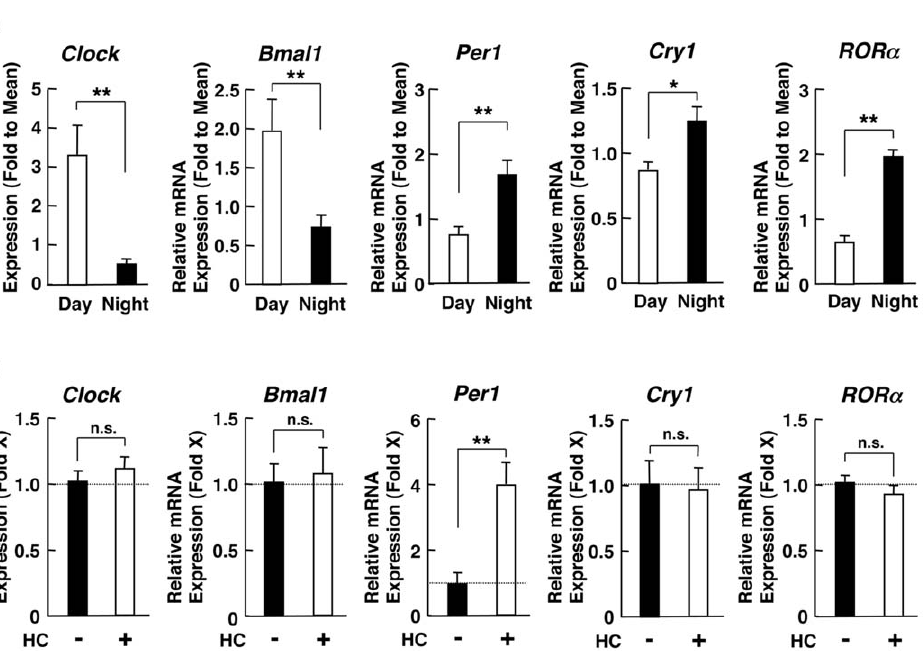
Figure 2. Daily change of CLOCK-related gene mRNA expressions in PBMCs (A) and their response to hydrocortisone in EBV- transformed peripheral lymphocytes (B). A: Morning and evening mRNA expression of CLOCK-related genes in PBMCs. Relative mRNA expression of Clock , Bmal1 , Per1 , Cry1 and ROR a at 8 am (Day) and 8 pm (Night) in PMBCs obtained from 10 healthy subjects is shown. The measurement was performed in duplicate for each subject. Bars represent mean 6 S.E. values of relative mRNA expression of the genes indicated. **: P , 0.01, compared to the conditions indicated (n=10, m=20). B: The effect of hydrocortisone on the mRNA expression of CLOCK-related genes in EBV-transformed peripheral lymphocytes. EBV-transformed peripheral lymphocytes were incubated with 5 6 10 2 7 M of hydrocortisone (HC) for 5 hours and mRNA expression of CLOCK-related genes was evaluated. The measurement was performed in triplicate. Bars represent mean 6 S.E. values of hydrocortisone (HC)-induced fold mRNA expression of indicated genes. **: P , 0.01, compared to the conditions indicated